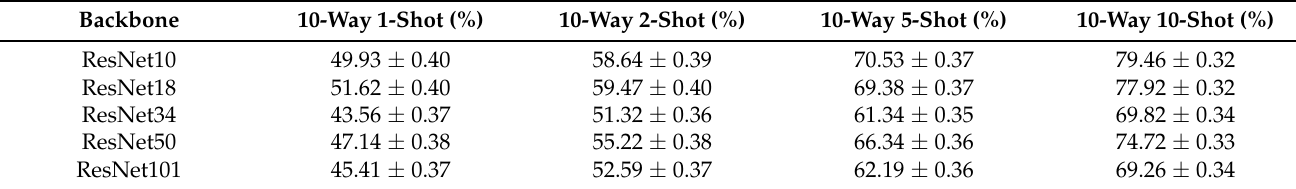
Table 2. Experimental results of replacing backbone.